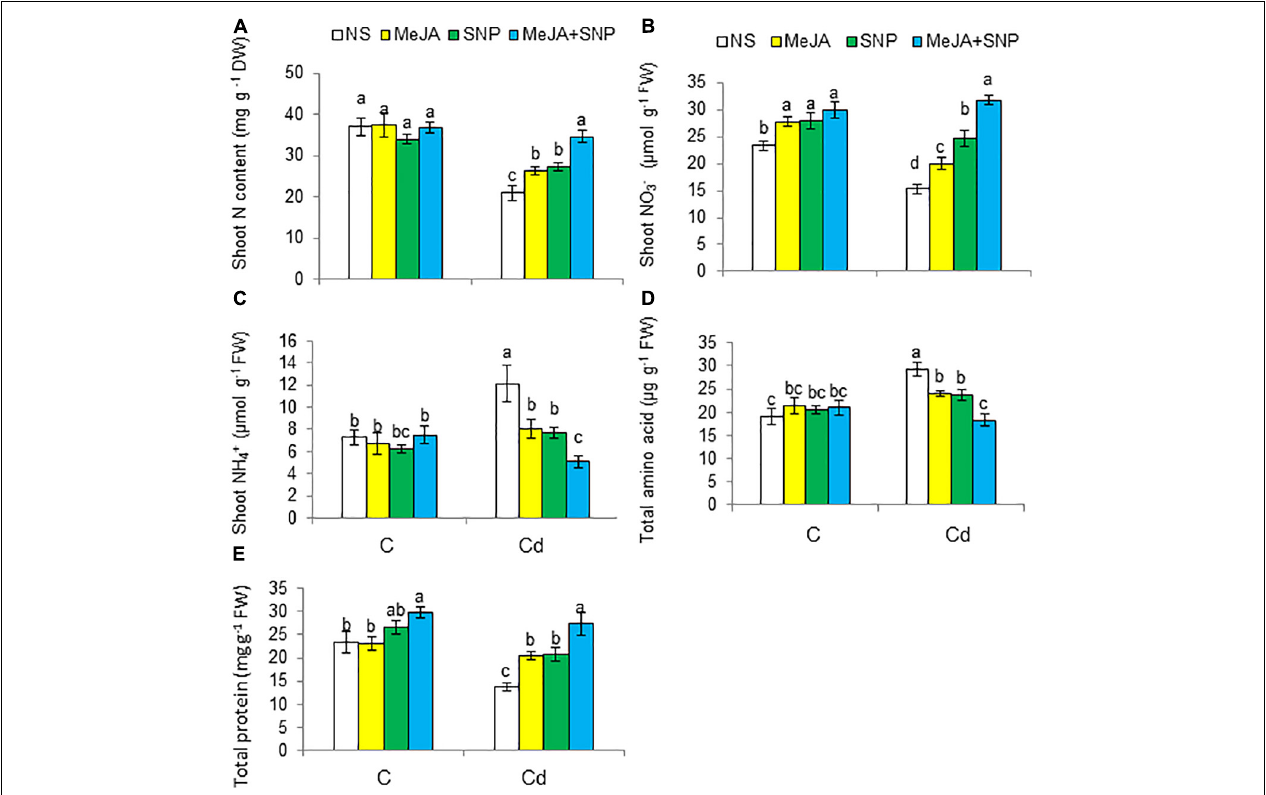
FIGURE 9 | Shoot total nitrogen [N (A) ] on dry weight (DW) basis, shoot nitrate [NO 3 - (B) ], shoot ammonium [NH 4 + (C) ], total amino acid (D) , and total protein (E) contents on fresh weight (FW) basis in wheat plants grown under control (C) and cadmium (100 µ M Cd) and sprayed with 10 µ M methyl jasmonate (MeJA) or 100 µ M sodium nitroprusside (SNP) alone or together (mean ± SE). Mean values carrying different letters within each attribute differ significantly ( P ≤ 0.05) based on Duncan multiple-range